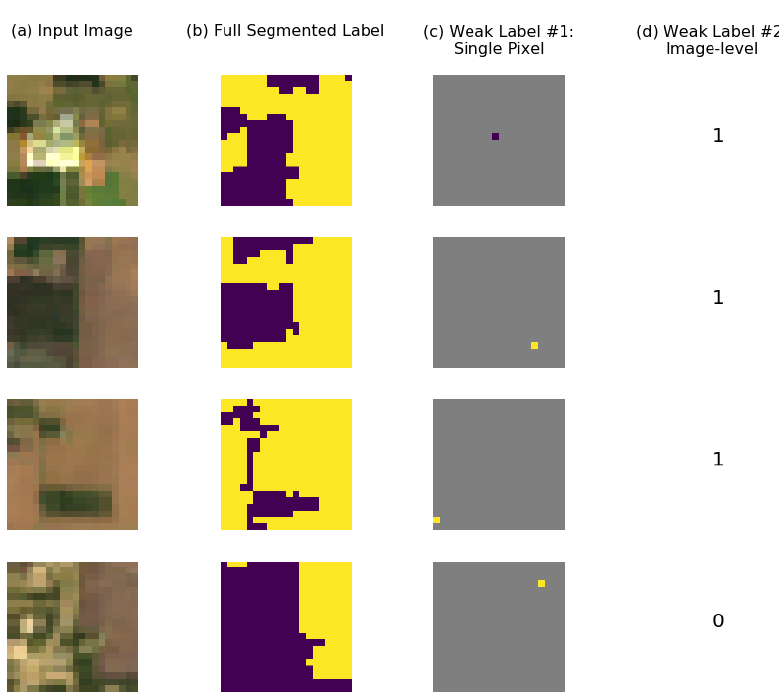
Figure 1. Examples of ( a ) Landsat images, ( b ) their corresponding full segmented labels, and ( c , d ) two types of weakly supervising labels. ( c ) Single pixel labels are available from datasets of geotagged points. Gray pixels’ labels are not known. ( d ) Image-level labels provide high-level information about the image but labels of individual pixels are not known. We demonstrate methods to predict the full segmented label, given only one of the weakly supervising